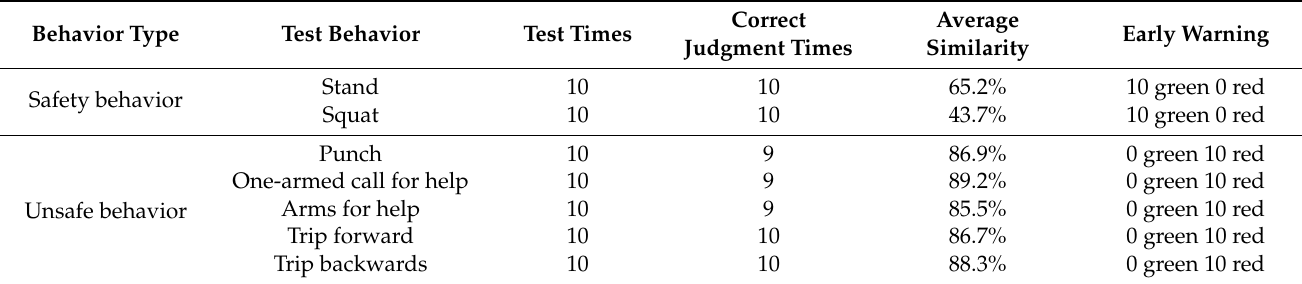
Table 11. Test results using the improved identification method.